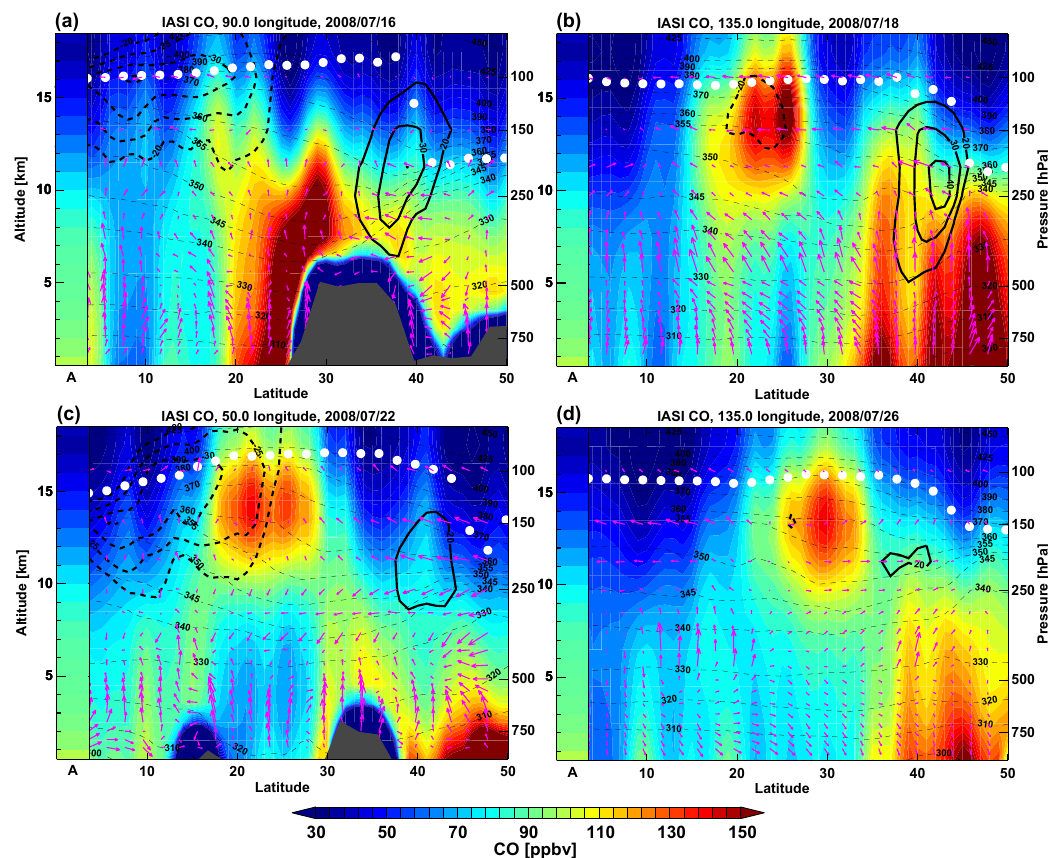
Figure 9. Selected latitude–height cross sections of the IASI CO retrieval. The retrieval a priori profile is shown as the leftmost column in each panel (marked as “A” on x axis). The days and the location of the cross sections are selected to highlight the different vertical structures of the three modes of the anticyclone: (a) 90 ◦ E on 16 July (Tibetan mode), (b) 135 ◦ E on 18 July (western Pacific mode), (c) 50 ◦ E on 22 July (Iranian mode), and (d) 135 ◦ E on 27 July (western Pacific mode). The corresponding maps are given in Figs. 7 and 8. A number of dynamical fields are overlaid, including zonal winds (black contours, solid (dashed) for westerly (easterly)), meridional wind (pink arrows), potential temperatures (thin black dashed lines), and the tropopause height (white